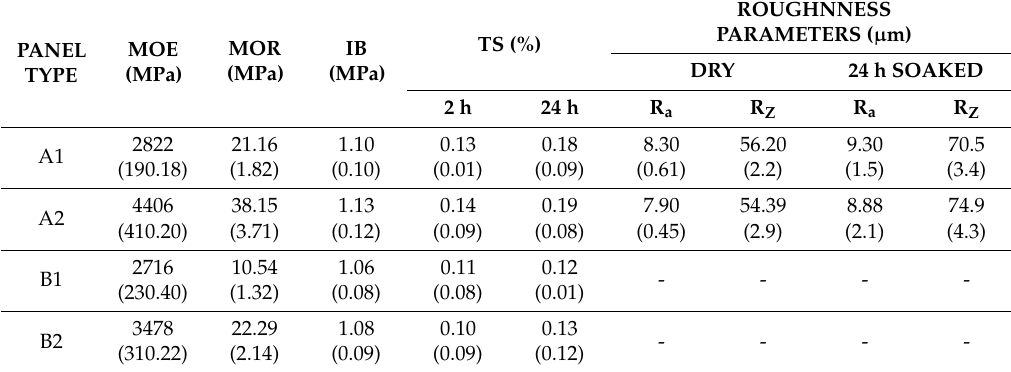
Table 1. Test results of the samples. (Numbers in parenthesis are standard deviation